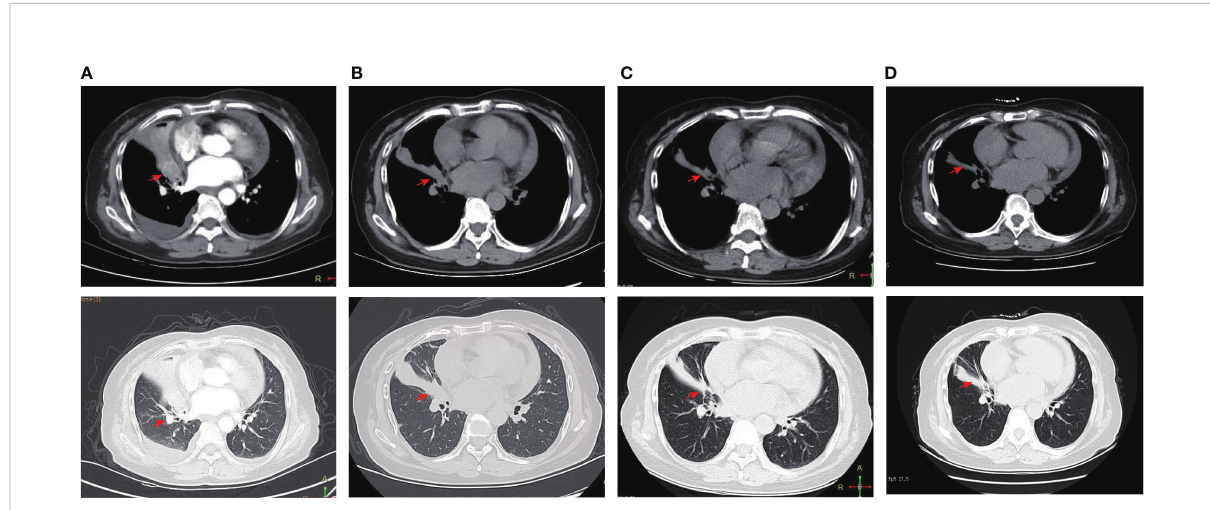
FIGURE 1 Dynamic imaging of lung lesions at different stages of treatment. (A) CT scan before alectnib treatment (March 1 st, 2022); (B) CT scan after two months of alectinib treatment (April 22 th, 2022); (C) CT scan after four months of alectinib treatment (June 29 th, 2022); (D) CT scan after six months of alectinib treatment (June 29th, 2022); note: the red arrow marks the location of the